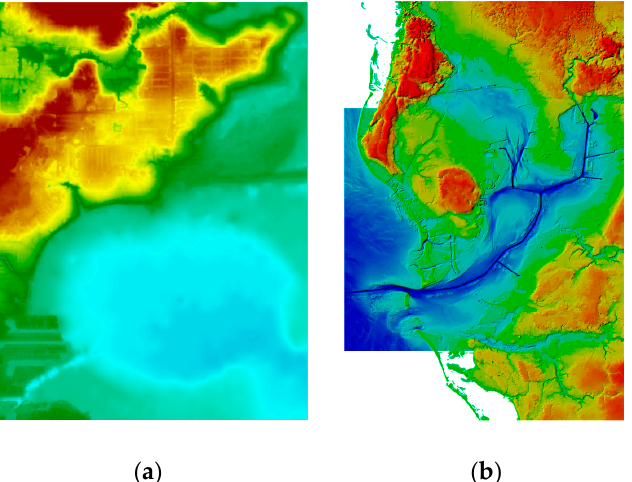
Figure 7. Results of the integration of ( a ) bathymetric and LiDAR data; ( b ) depth and topographic data according to [40].